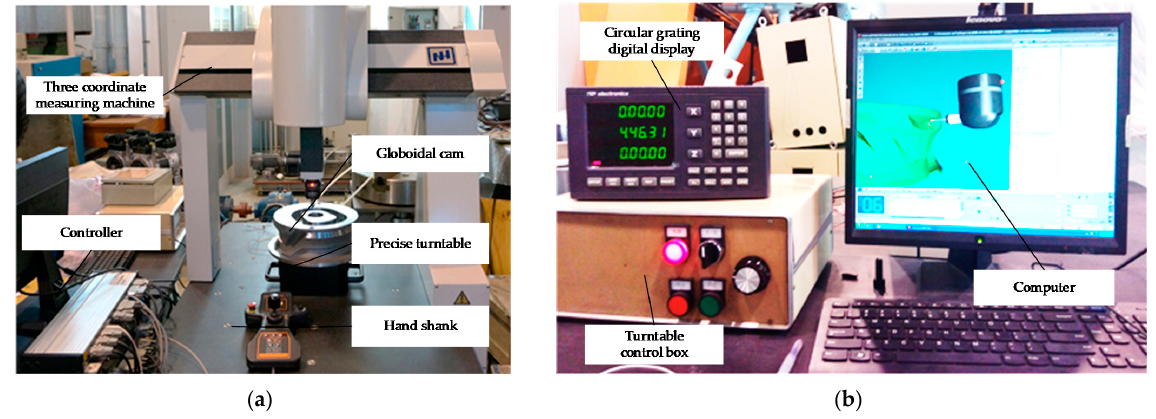
Figure 9. Equipment of measurement system control. ( a ) Equipment of measurement system control I; ( b ) Equipment of measurement system control II.